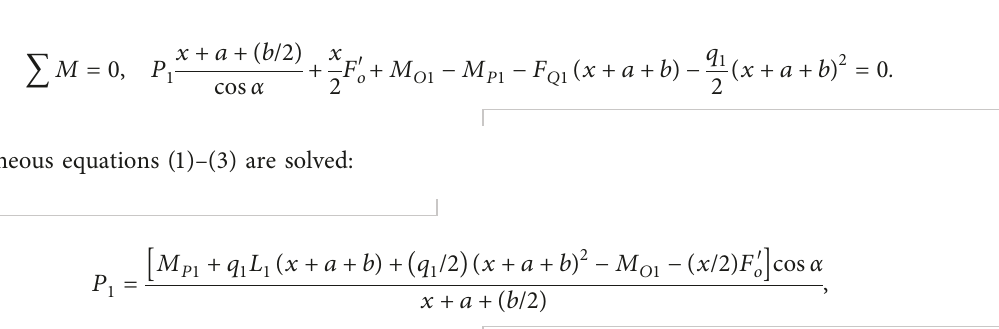
Figure 2: Force model of GSSB. (a) Initial stage and (b) later